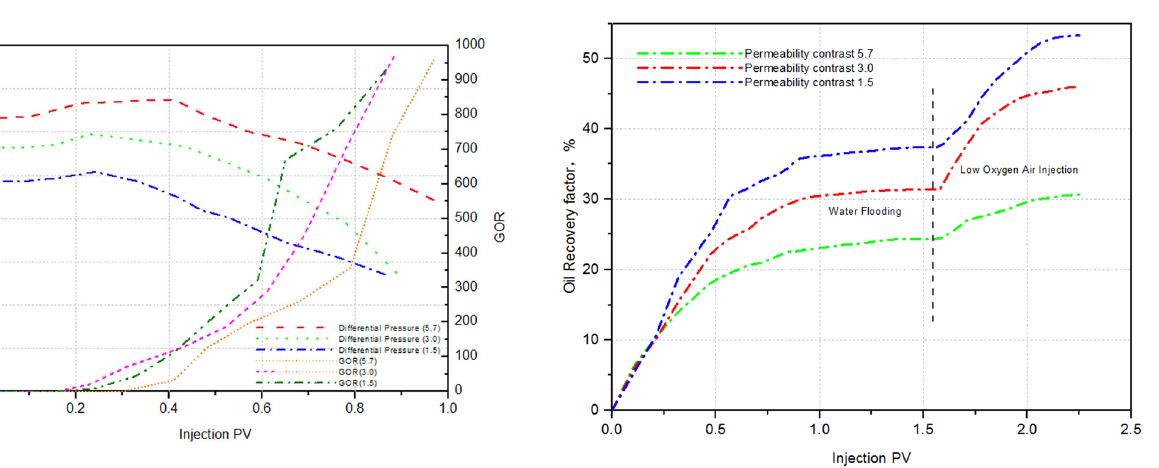
Fig. 8 Oil recovery factor curves of consecutive injection